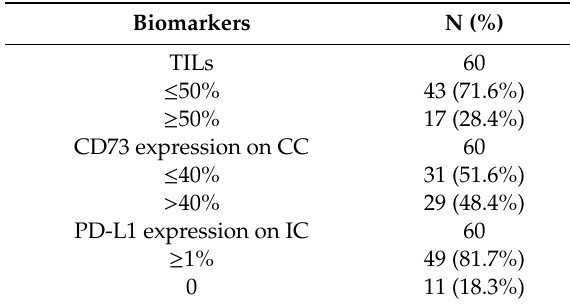
Table 3. Pre-NACT biomarkers